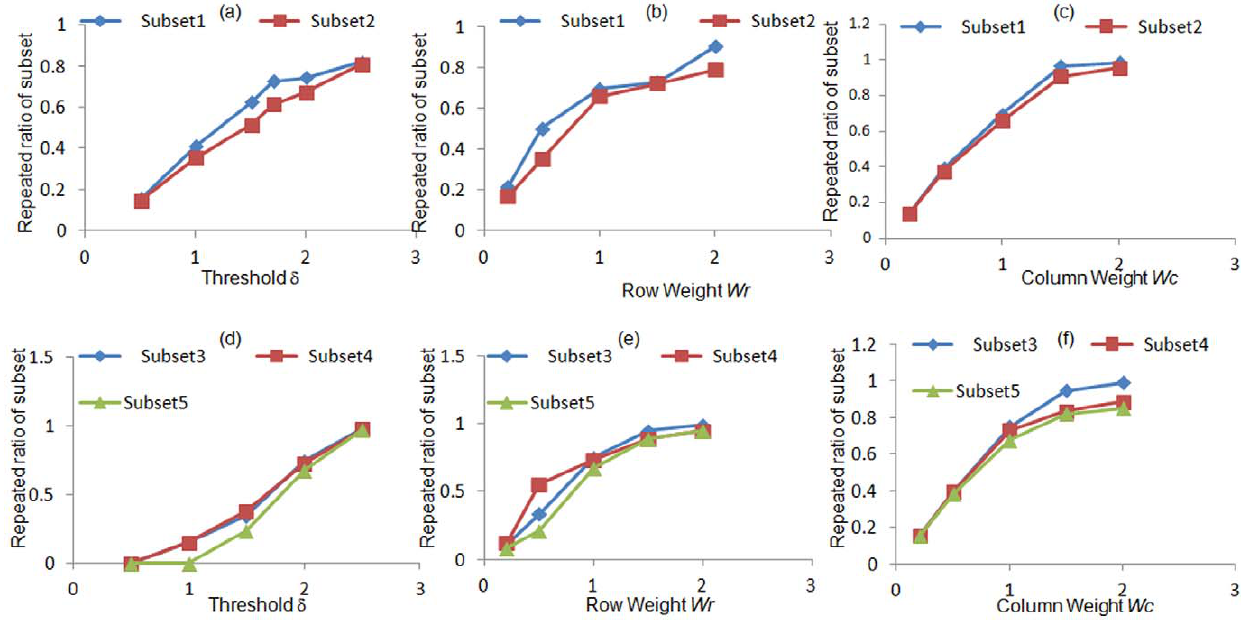
Figure 8. Sensitivity of the identified robust bi-cluster on model parameters. Bi-cluster of the bootstrap data identifies 2 robust bi-clusters for 2-dimensional dataset and 3 robust bi-clusters of the 3-dimensional dataset. Figures (a-c) illustrates the frequency of repeats of the robust bi- clusters to threshold d (a), row weight W r (b) and column weight W c (c) for 2-dimensional culture; Figures (d-f) represents the same for 3-dimensional culture.